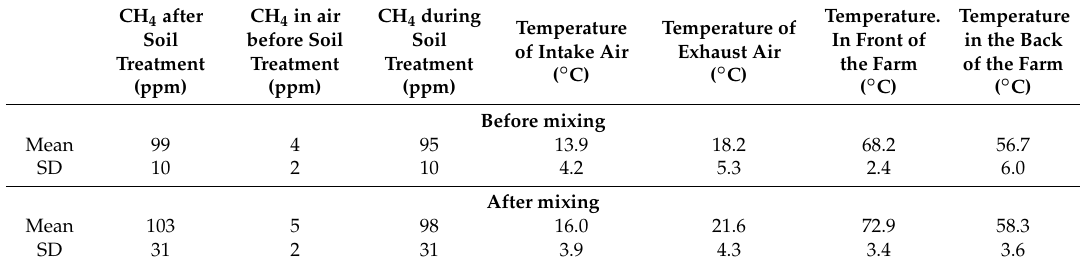
Table 4. Methane concentration and temperature according to process of soil treatment.